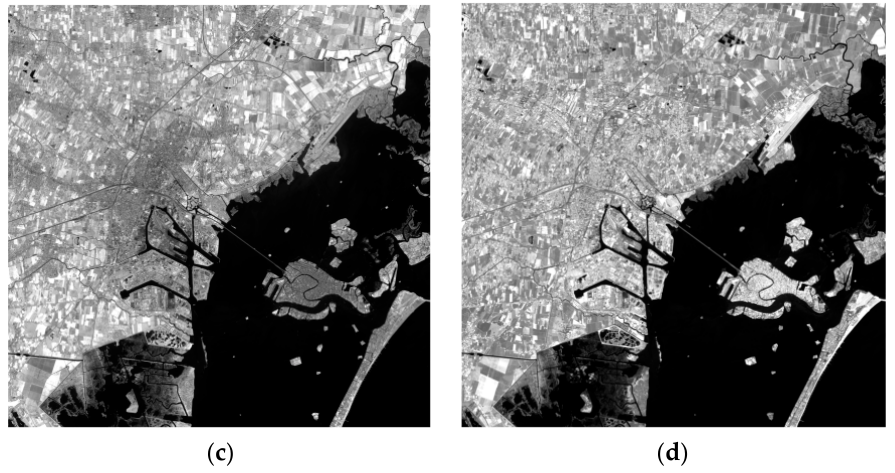
Figure 1. ( a ) Ten-metre false colour map (R: Band 4; G: Band 3; B: Band 8); ( b ) 10-m green Band 3; ( c ) 10-m NIR Band 8; ( d ) 20-m SWIR Band 11.